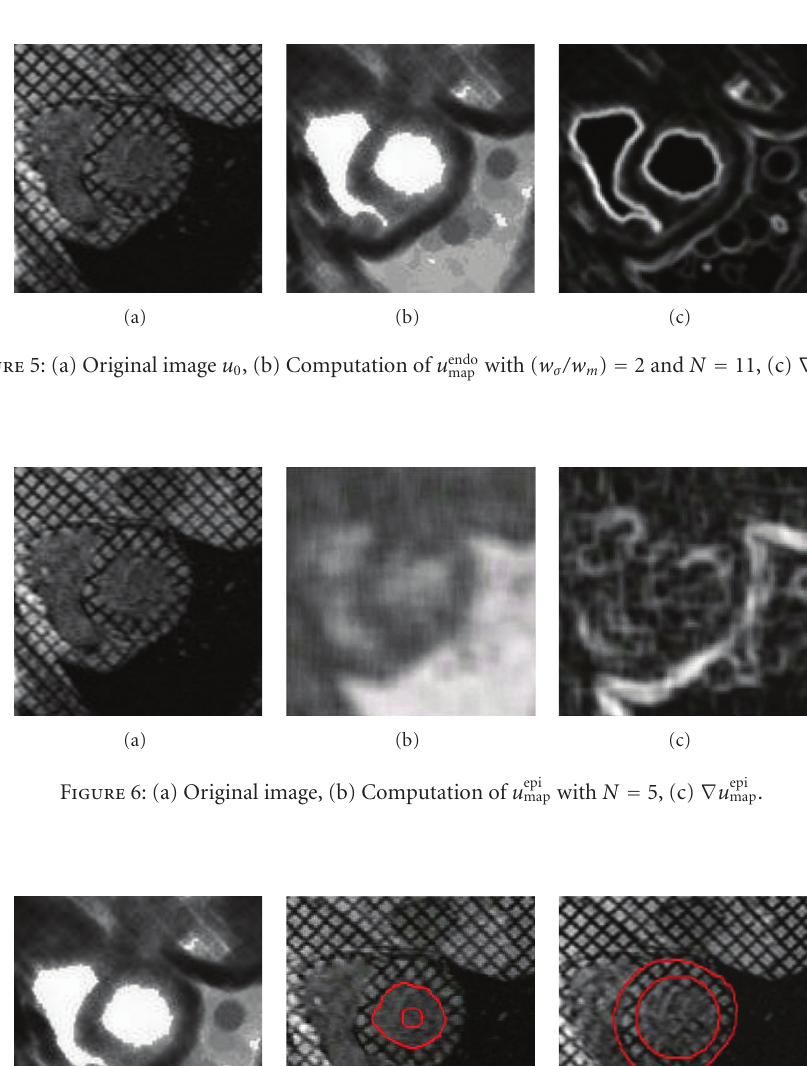
Figure 7: (a) Computation of u endo with ( w σ /w m ) = 2 and N = 11 for automatic localization of the barycenter of LV cavity, (b) initialization map and detection of endocardial boundary, and (c) initialization and detection of epicardial boundary.